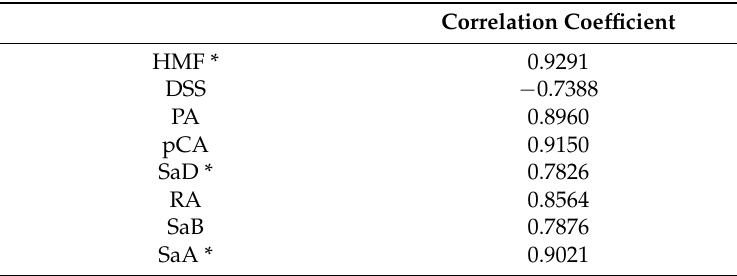
Table 1. The correlation coefficients between the anti-thrombotic effect and the contents for major compounds in